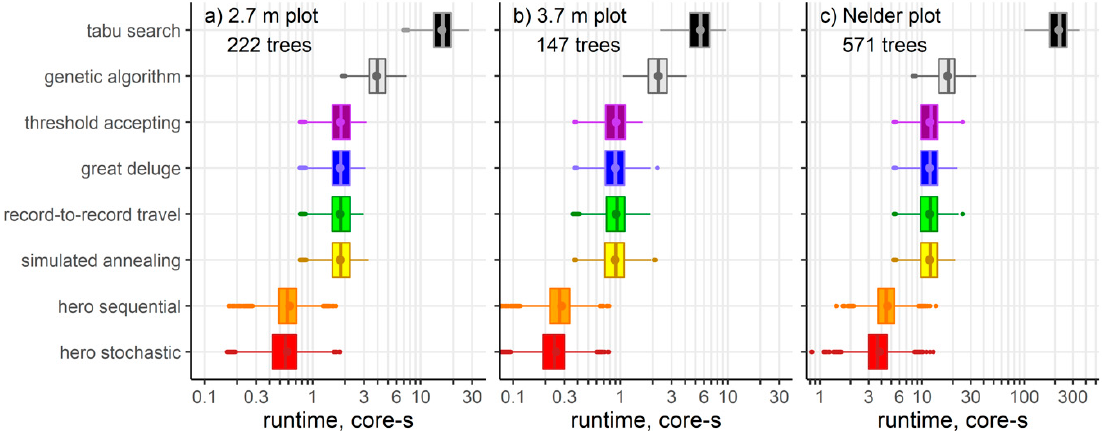
Figure 5. Boxplots of the elapsed time required to run each of the eight heuristics on each plot using an Intel i7-3300 quad-core processor with a 3.3 GHz base clock. One core-second represents the use of one processor core for one second. Since all heuristics obtained similar LEVs, heuristics with shorter runtimes would typically be preferred.